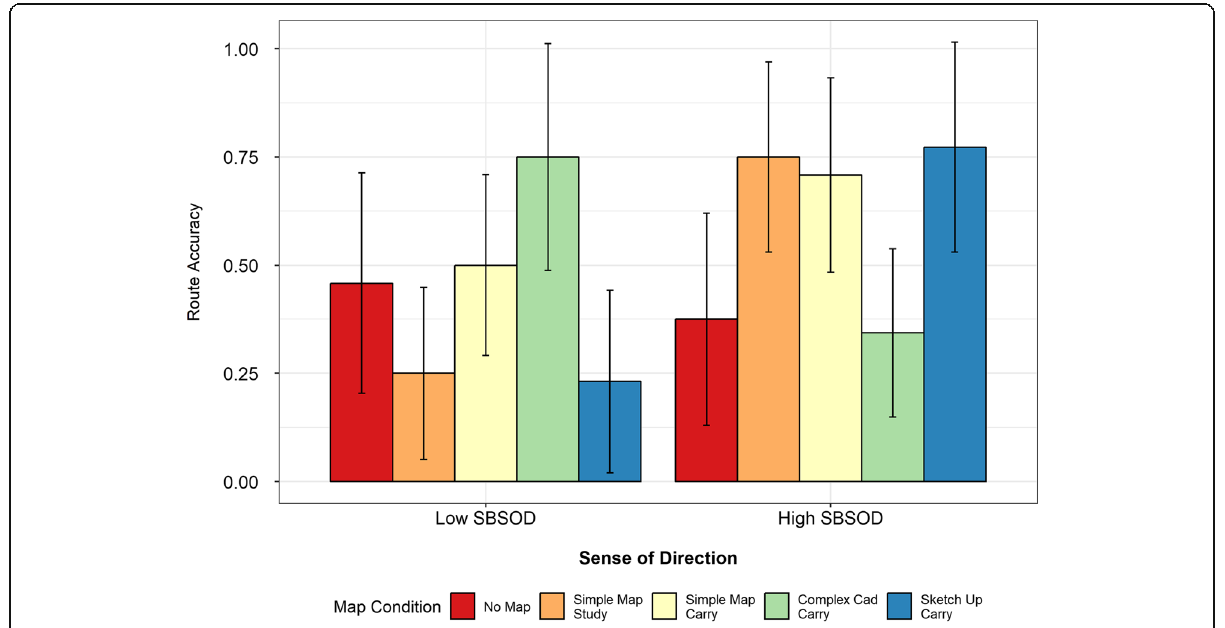
Fig. 11 Map completion task route accuracy scores as a function of map condition, split by sense of